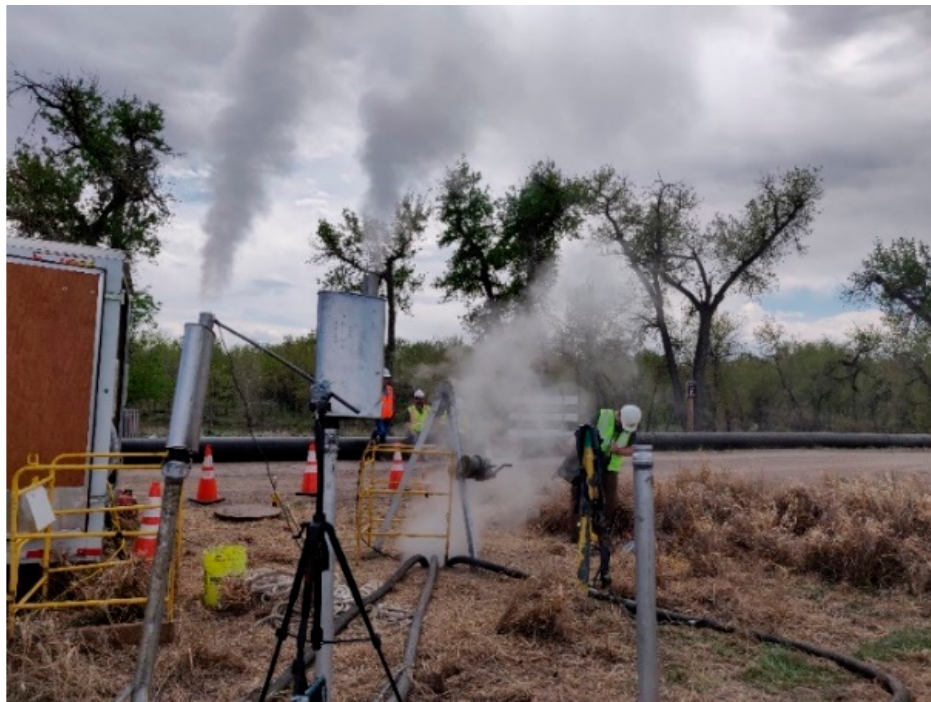
Figure 3. Stack Configuration at Aurora Site.